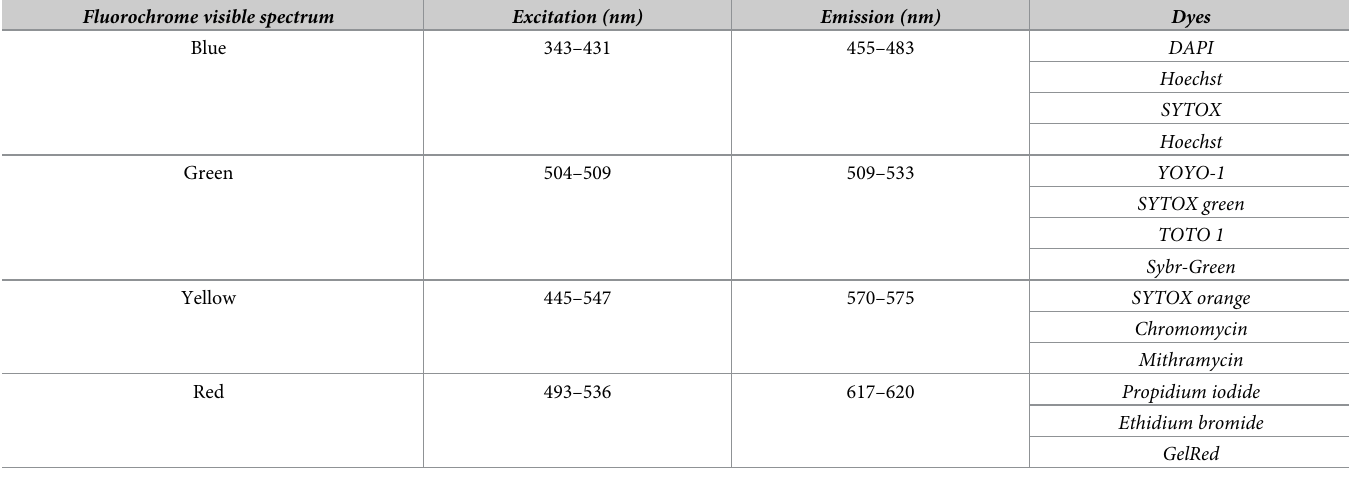
Table 1. Excitation and emission wavelengths for commonly available commercial dyes. Fluorochrome visible